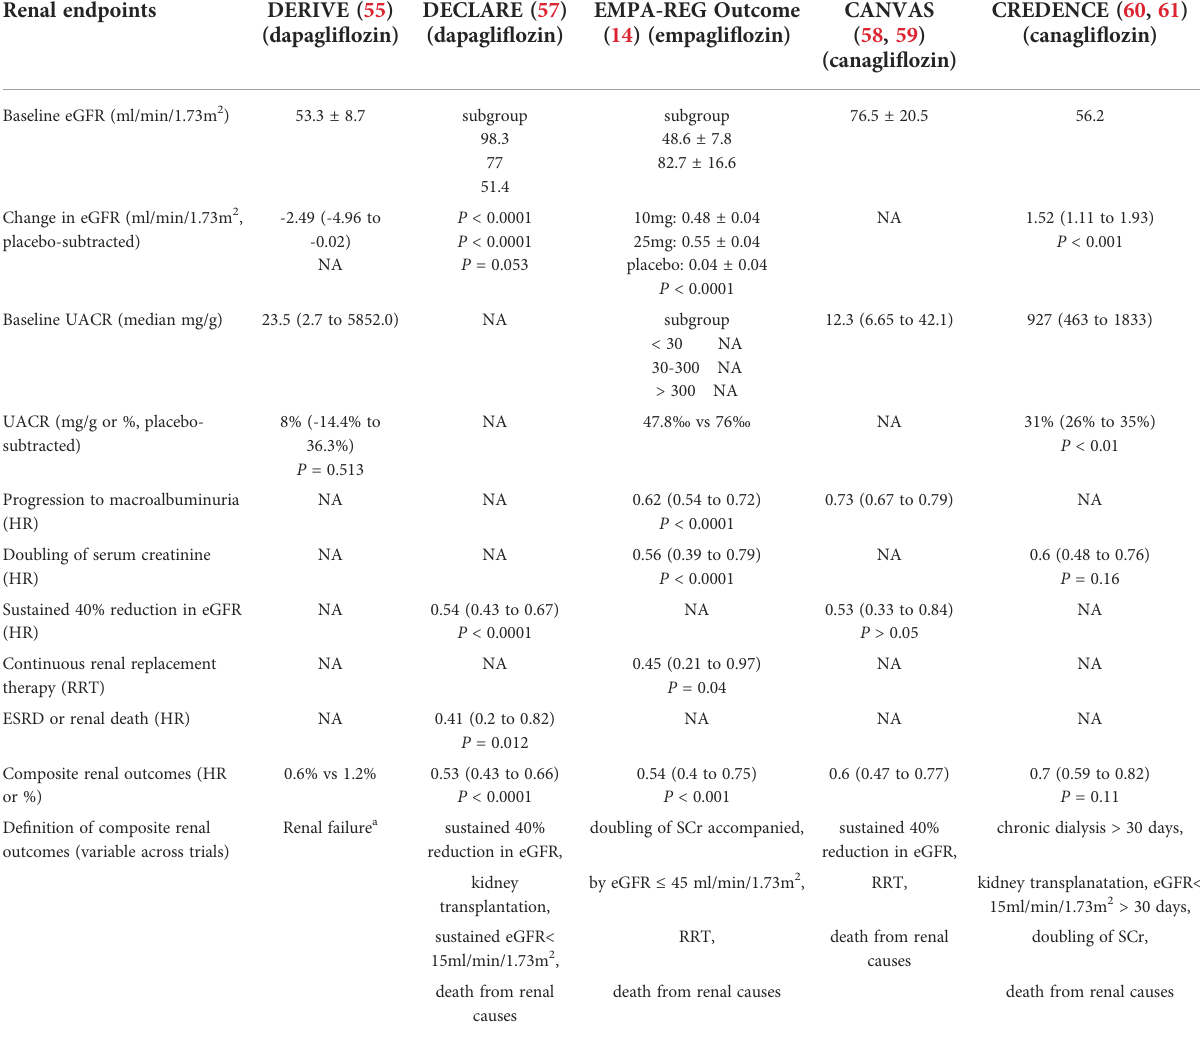
TABLE 4 Renal outcomes in type 2 diabetes patients treated with Sodium-glucose cotransporters 2 (SGLT2) inhibitors in fi ve major cardiovascular outcome